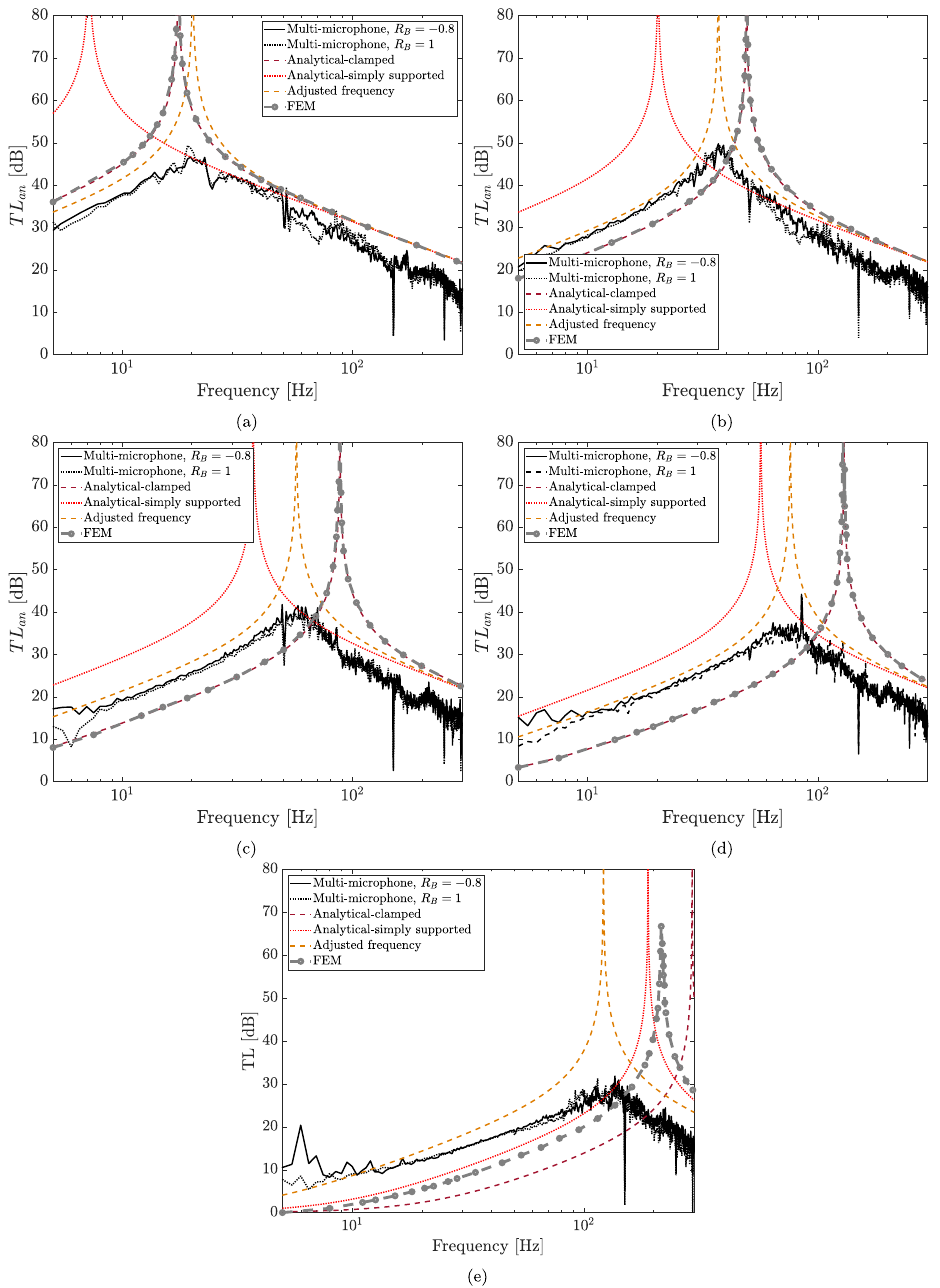
Figure 6. Comparison between measured, analytically estimated and FEM estimated TL an of fl exible plate resonators with t plate = 1 mm (a), 2 mm (b), 3 mm (c), 4 mm (d) and 10 mm (e). The measured TL an have been calculated using the multi-microphone method for both terminations. The adjusted frequency fi t TL an value is estimated from a visually guess of the maximum response frequency f max from the